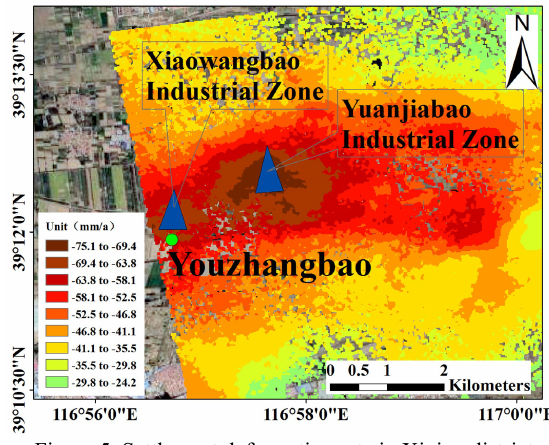
Figure 5. Settlement deformation rate in Xiqing district